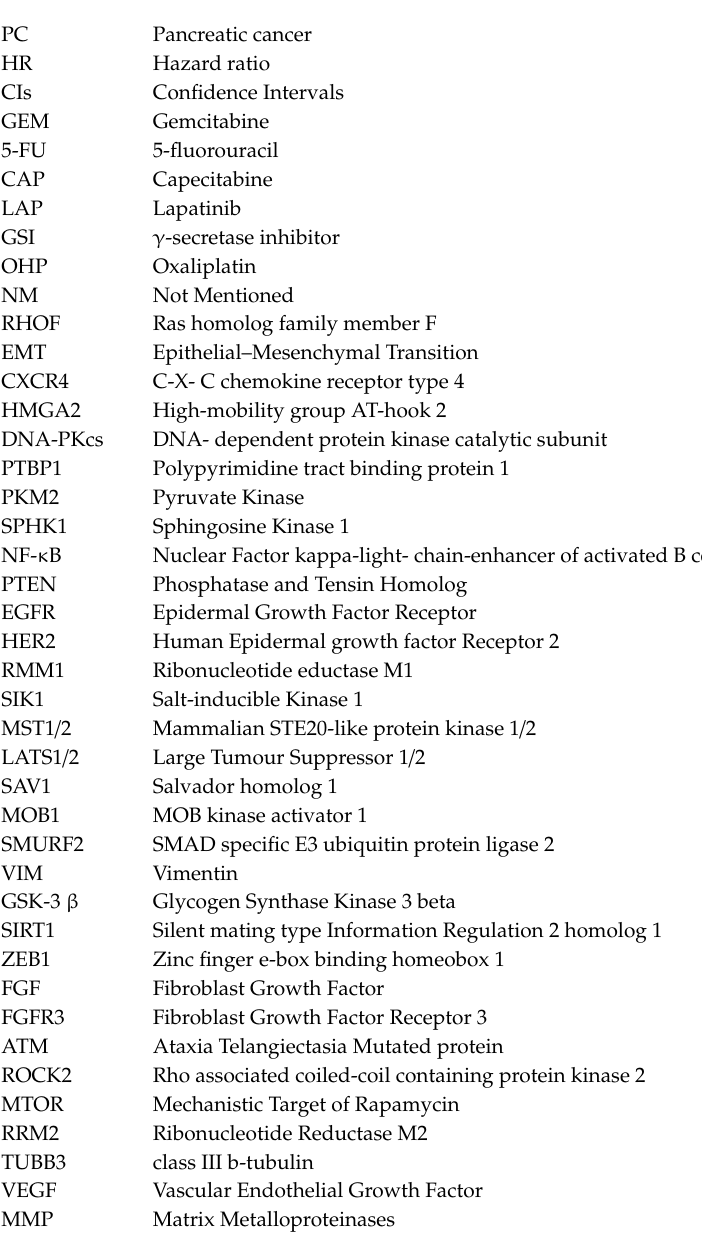
Table S1: The search strategy, Table S2: Quality assessment of the included